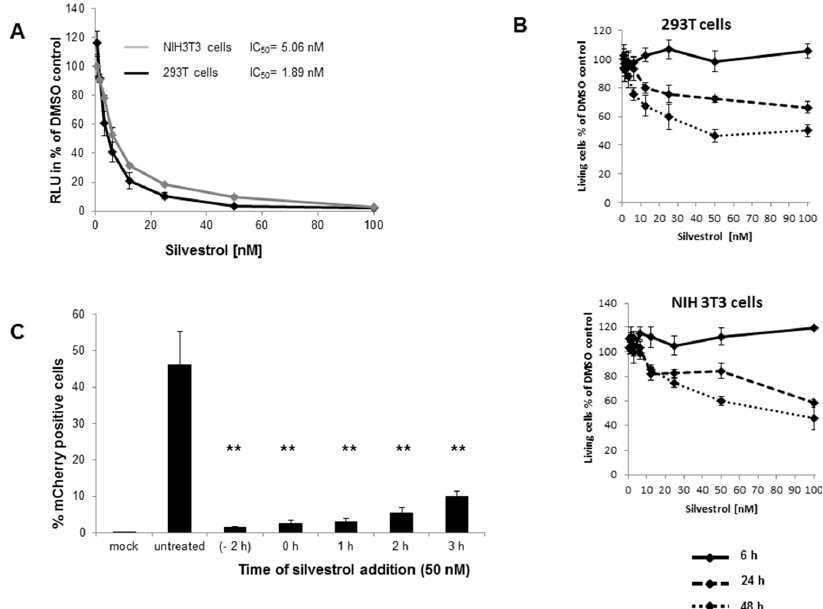
Figure 1. Silvestrol treatment inhibits chikungunya virus (CHIKV) replication. ( A )